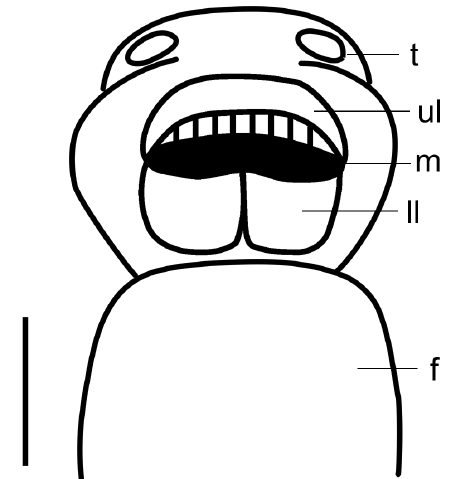
Figure 11. Buccal morphology of Ventania avellanedae . (f) foot, (ll) lower lip, (m) mandible, (t) tentacle, (ul) upper lip. Scale bar: 1 mm.